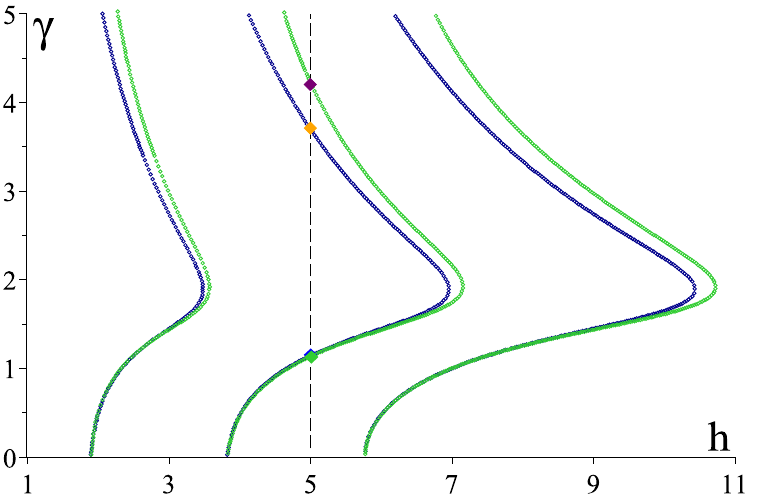
(blue curve) and problem with β = 0 (red curve). Solid P α P 0 1.415 (red) , (cid:101) γ 2 0.902 (green) of problem ≈ ≈ 1.141 (brown), γ 2,2 3.705 (blue) of problem ≈ ≈